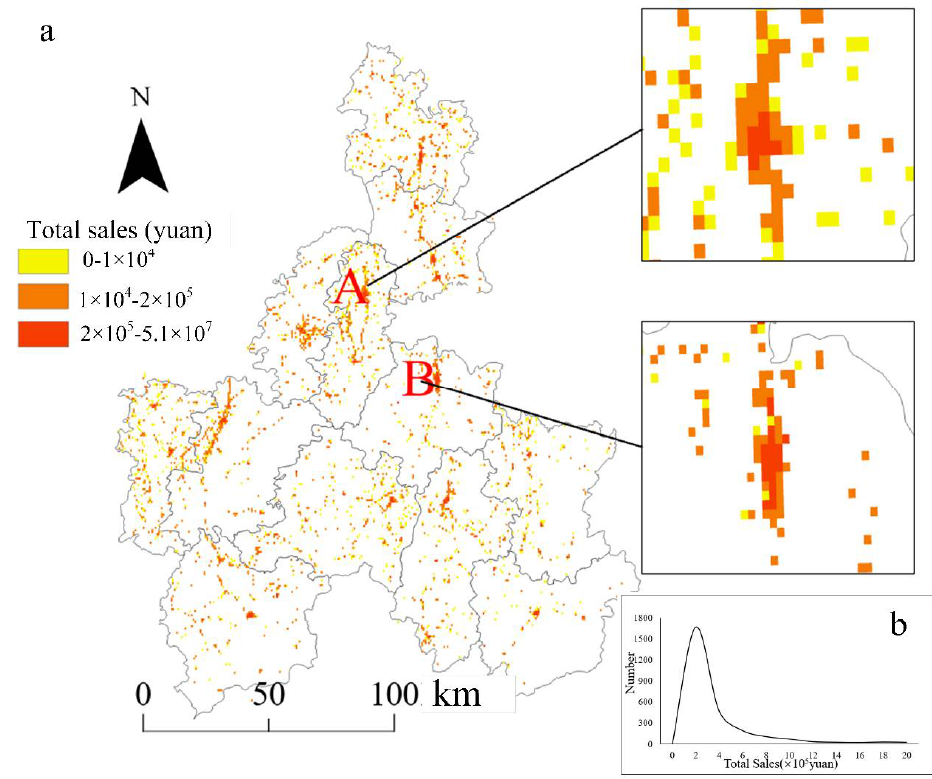
Figure 6. ( a ) Spatial distribution of total retail sales in each grid. ( b ) Relationship curve of the number of shops and total retail sales in the grid scale.